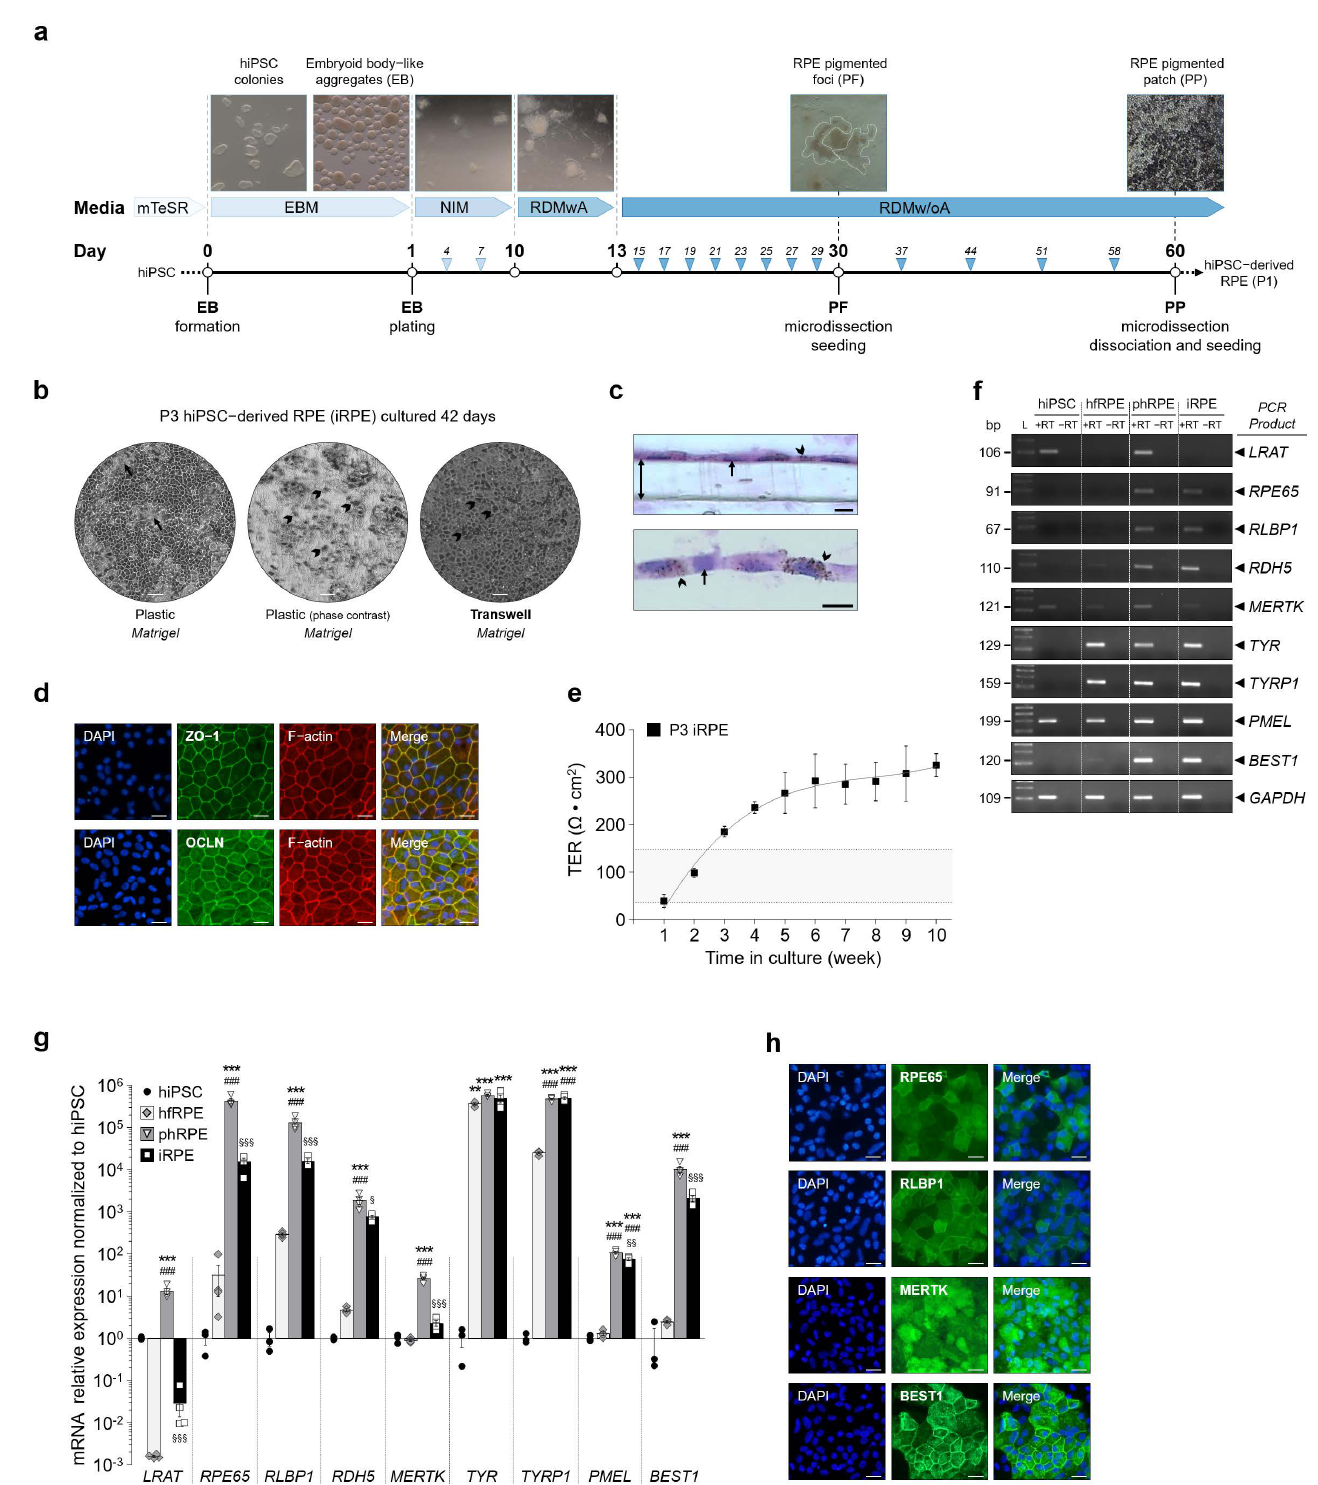
Figure 1. Human induced pluripotent stem cell (hiPSC)-derived RPE cells (iRPE) express RPE characteristic marker genes and exhibit transepithelial resistance. ( a ) Protocol used to expand and differentiate hiPSC into human iRPE cells in 60 days. RPE pigmented foci are marked by white dashed lines. ( b ) Monolayer of pigmented iRPE cells at passage 3 (arrowhead). When grown on plastic, iRPE cells form dome-like cellular structures across cell culture (arrow). ( c ) Transversal sections of pigmented iRPE cells cultured on transwell (double arrow). Pigment granules (arrowhead).